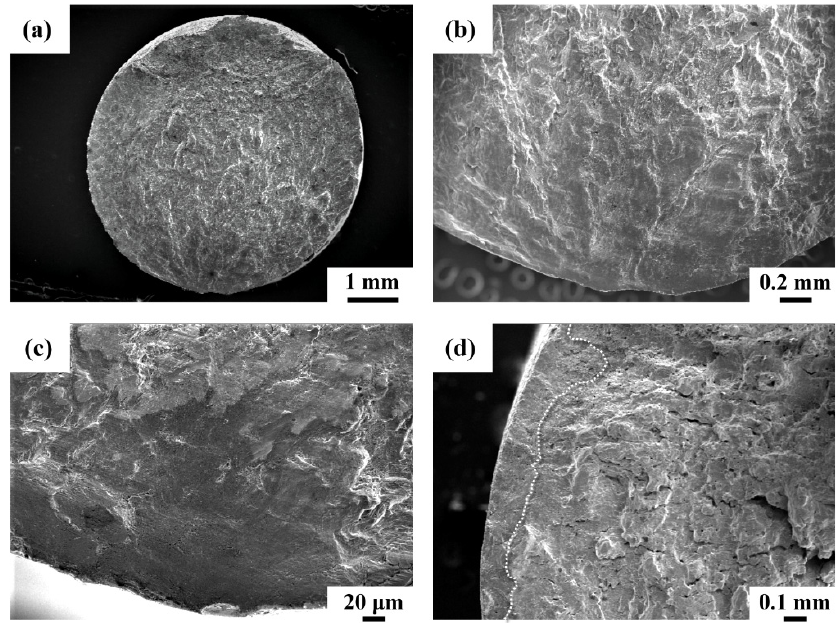
Figure 12. ( a ) Macro-fatigue appearance of the shot-peened sample, ( b ) rubbed zone at the crack initiation site, ( c ) the same area of ( b ) at higher magnification, ( d ) rubbed layer around the circum-